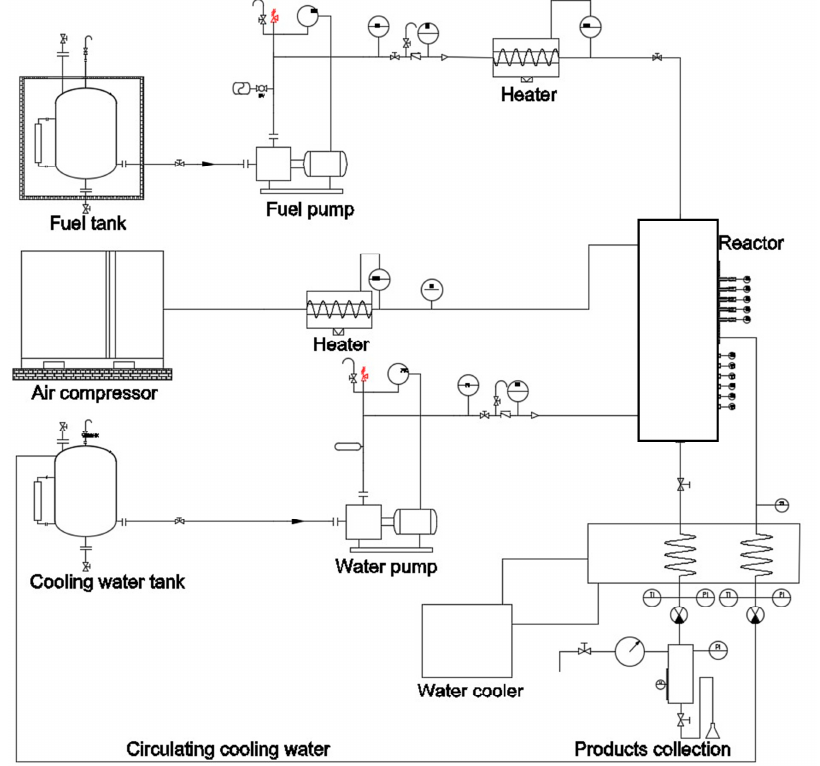
Figure 1. Flow diagram of the facility.